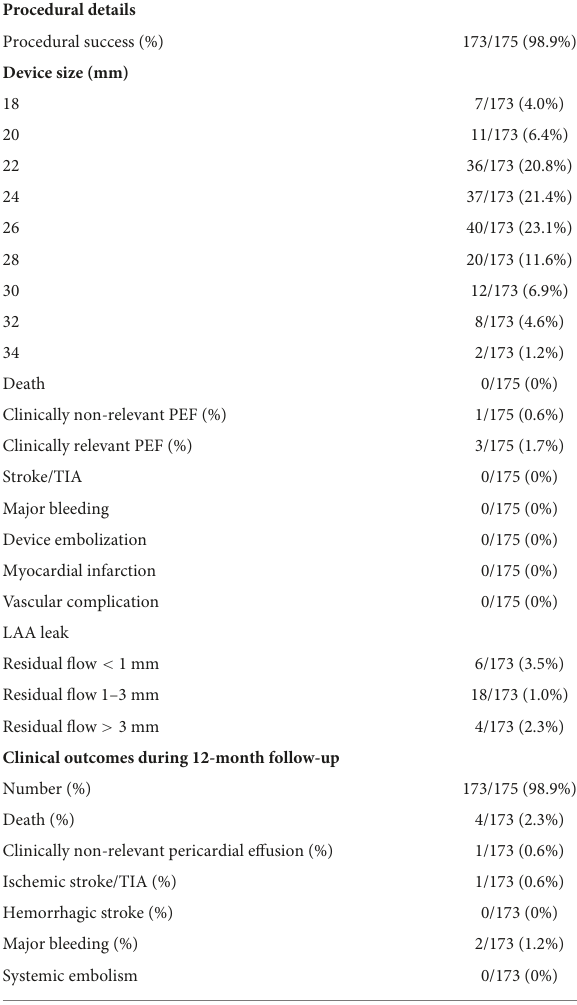
TABLE 2 Procedural details and clinical outcomes at